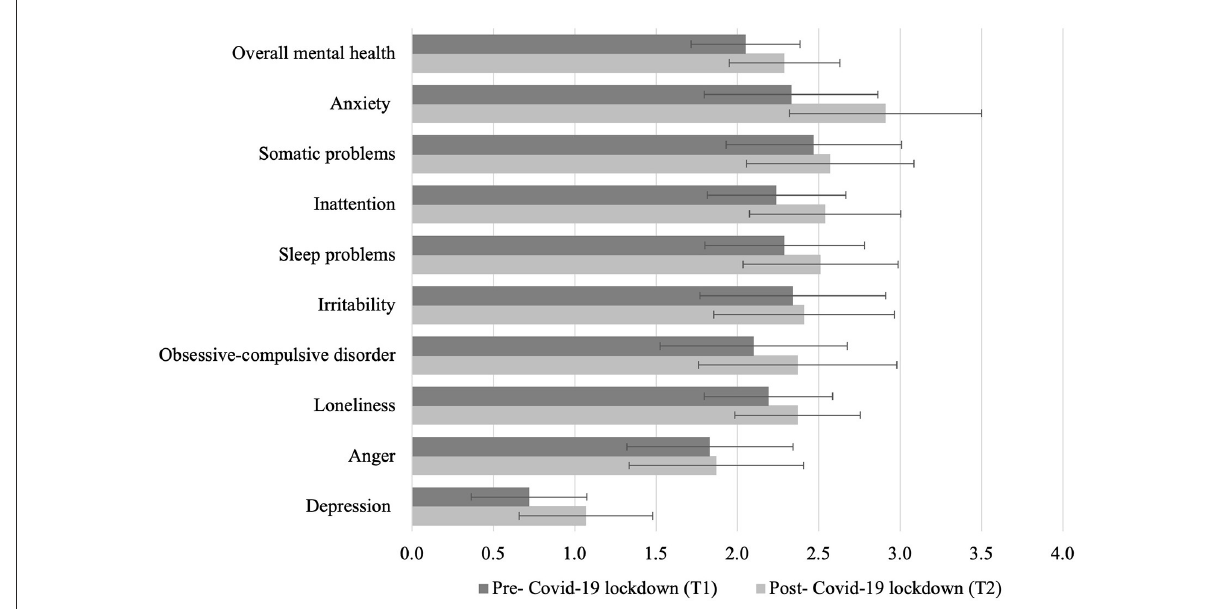
FIGURE1 Mental health before and after the COVID-19 lockdown in Switzerland. Means and standard deviations are shown.